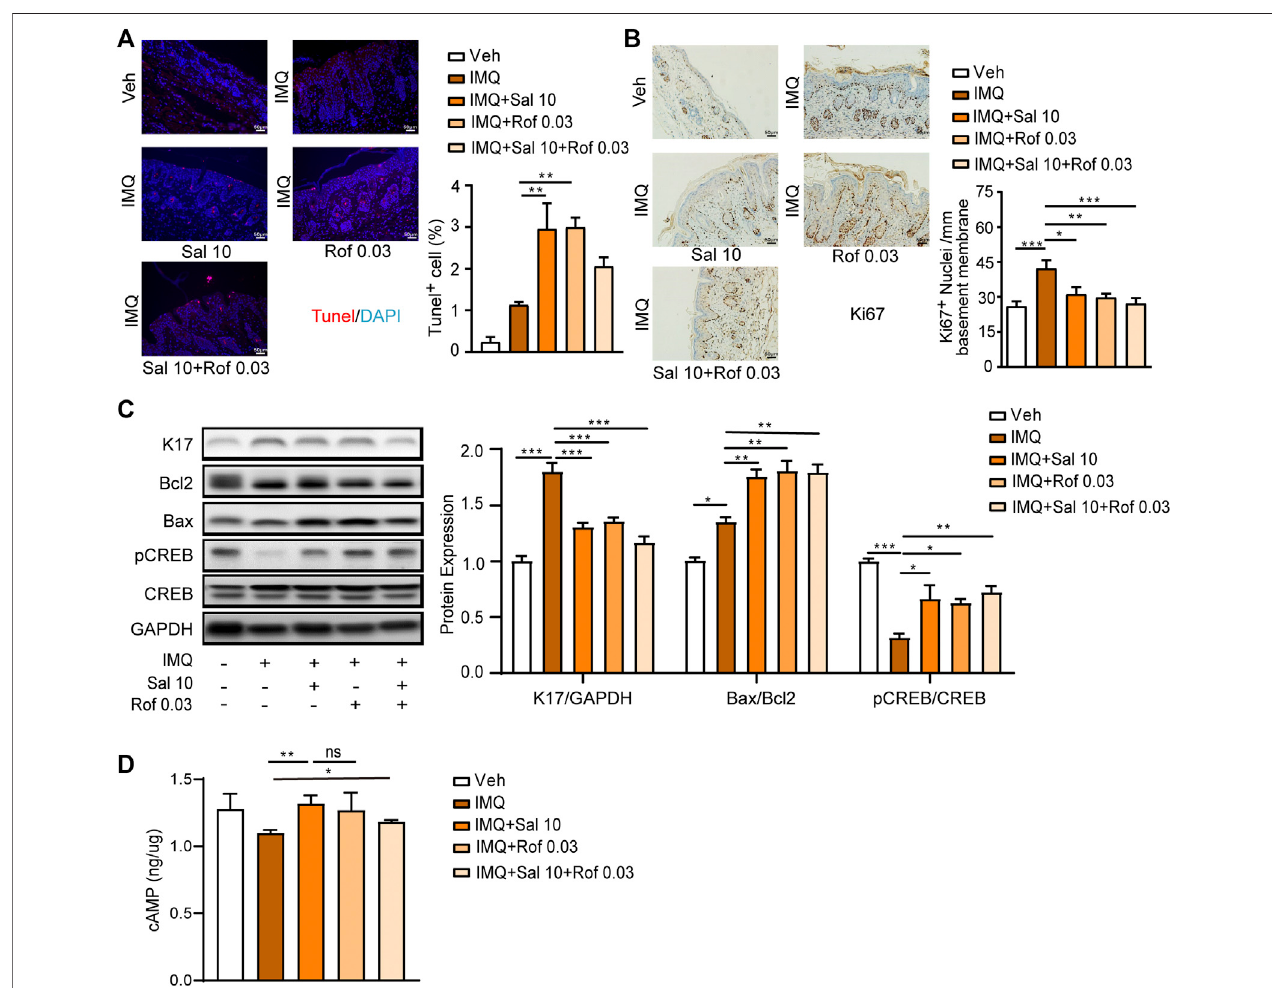
FIGURE6| Effectsofsalmeterol,ro fl umilast,andsalmeterolcombinedwithro fl umilastoncellproliferationandapoptosisintheepidermisofmicewithIMQ-induced psoriasis. Psoriasis-like dermatitis was induced by IMQ in mice. Sal, Rof, and the combination of Sal and Rof were subcutaneously administered under the skin for 5 days. (A) RepresentativeTUNELstainingofcross-sectionalsectionsofthebackskinofmiceonthesixthday( n =3;×200,Scalebar=50 μ m). (B) RepresentativeKi67 stainingofcross-sectionalsectionsofthebackskinofmiceonthesixthday( n =3;×200,Scalebar=50 μ m). (C) ExpressionlevelsofK17,Bcl2,Bax,pCREB,and CREBinthebackskinweredetectedbyWesternblotting.GAPDHservedastheloadingcontrol( n =4). (D) cAMPlevelsweredetectedinskintissues( n =4 – 7).Dataare presented as the mean ± SEM. (A – C) * p < 0.05, ** p < 0.01, and *** p < 0.001 by one-way ANOVA followed by Tukey ’ s post-hoc test. (D) * p < 0.05 and ** p < 0.01by unpaired t test. ns, not signi fi